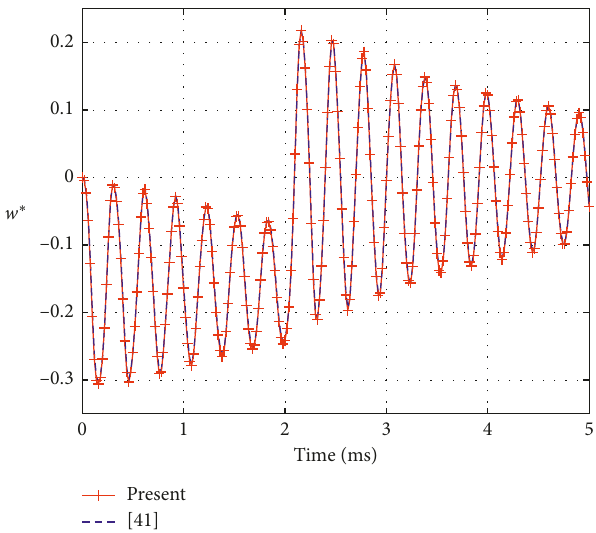
Figure 3: The deflection of the center point of the structure over